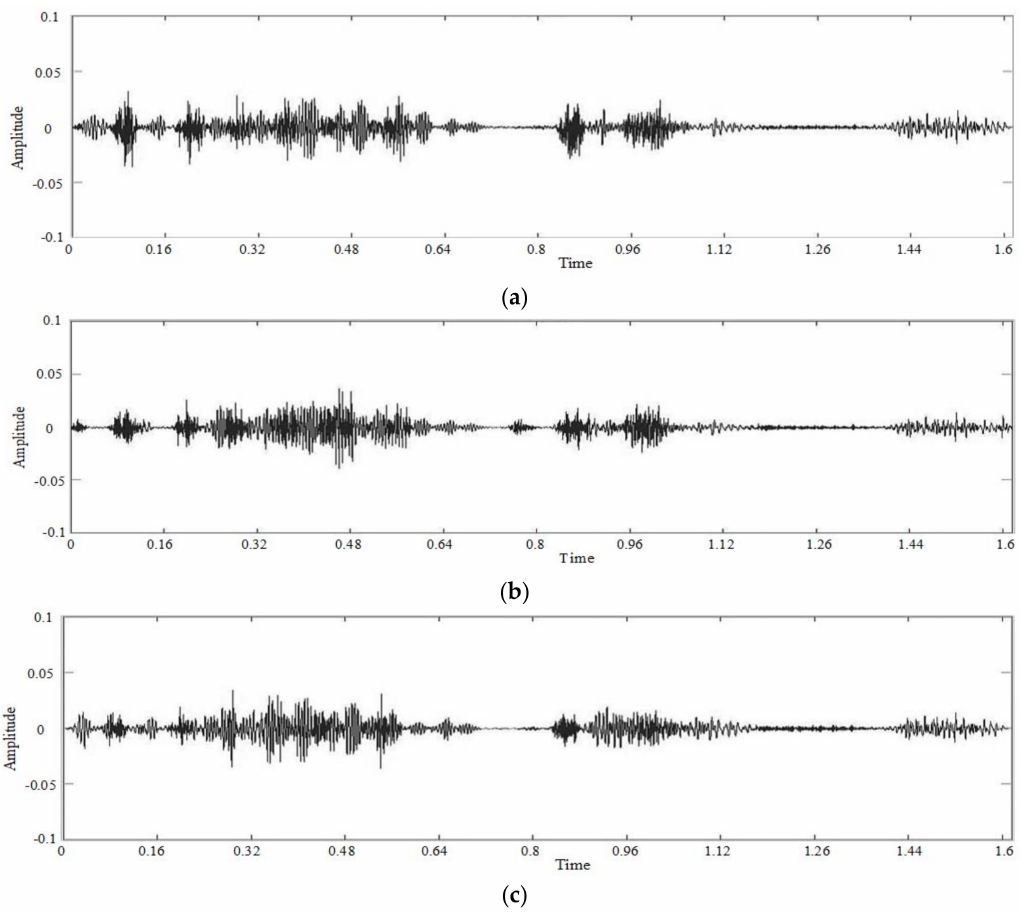
Figure 17. Waveforms of recovered speech signal by using different iterations of DNN ( a ) 100 iterations ( b ) 200 iterations( c ) 500 iterations.